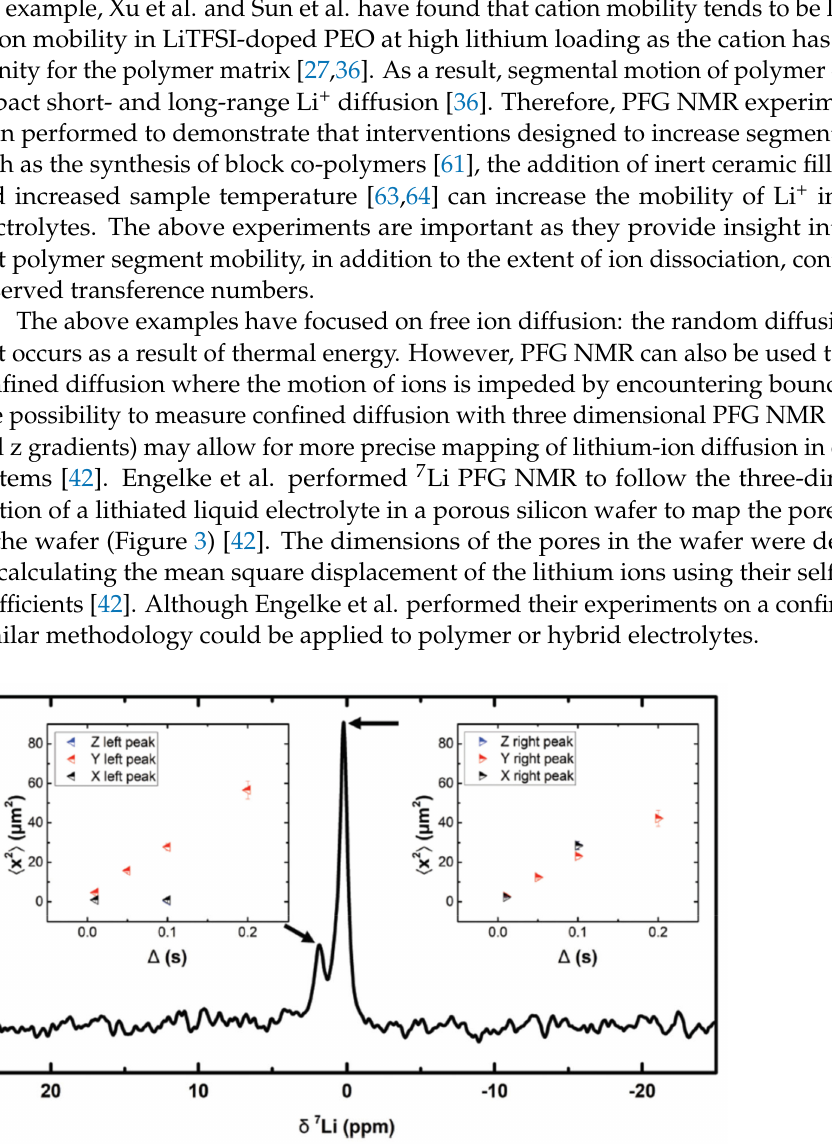
Figure 3. One dimensional slice from a 7 Li PFG NMR (7.1 T) experiment of lithiated liquid electrolyte in a porous silicon wafer. The inserts show calculated mean square displacements for each lithiated environment as a function of diffusion time. Reproduced from ref. [42] with permission from the PCCP Owner